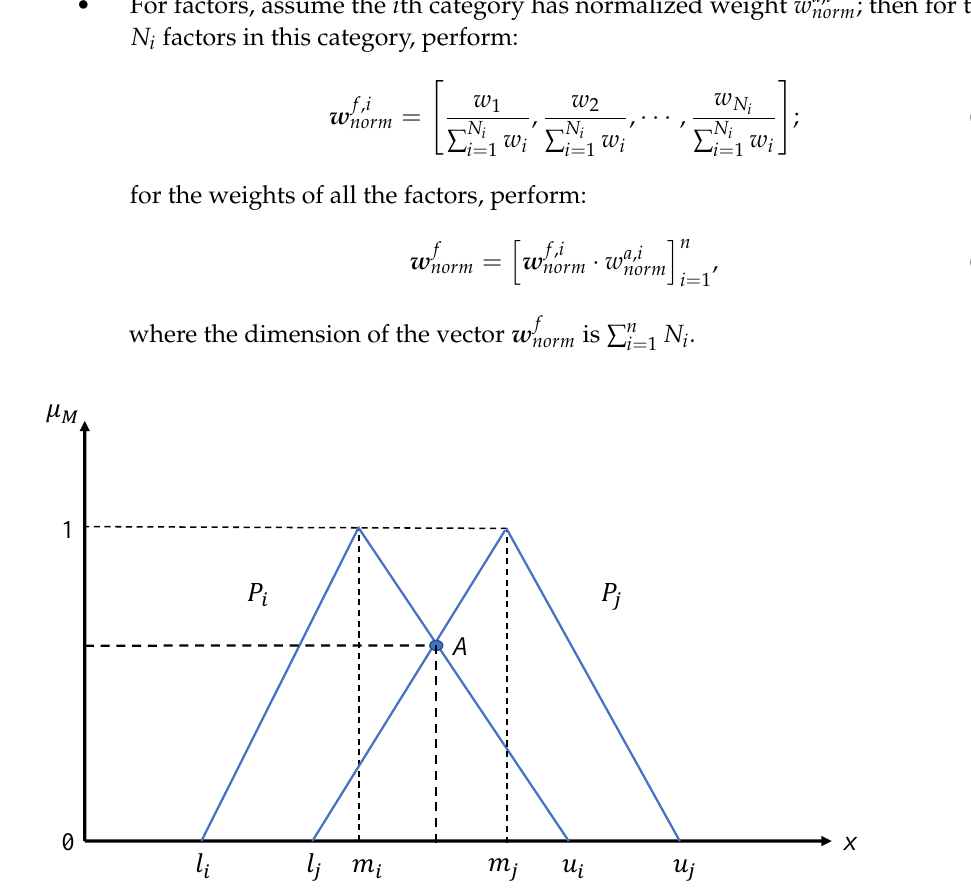
Figure 3. The comparison between two triangular fuzzy